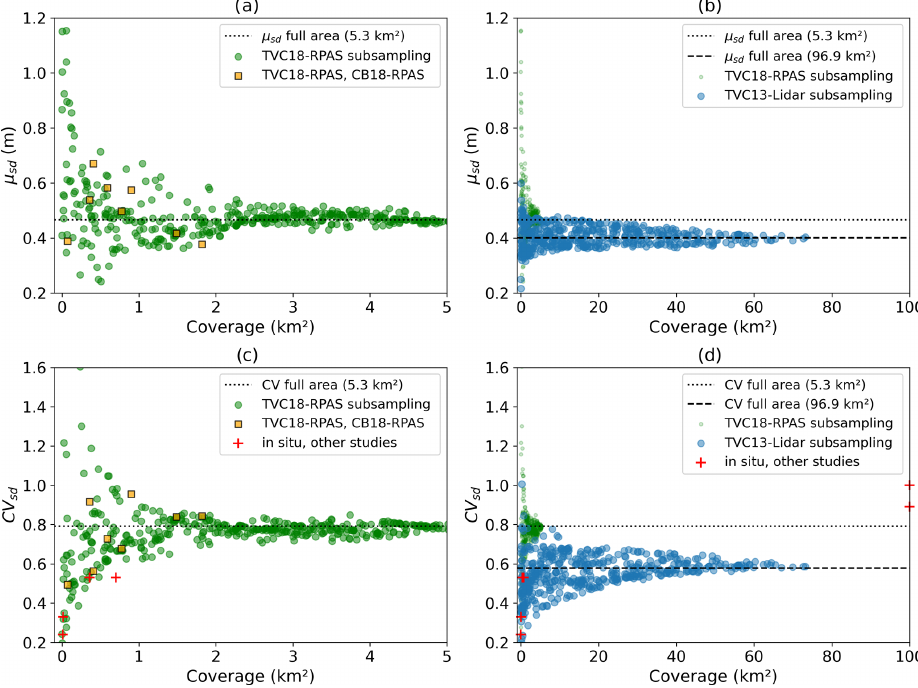
Figure 4. Snow depth mean ( µ sd ) (a, b) and variability (CV sd ) (c, d) as a function of coverage for sampling area: (a, c) small area; (b, d) large area. Monte Carlo simulations were done using the two datasets in TVC. CB18-RPAS was also added in panels (a) and (c) because of the similar coverage. The µ sd and CV sd of both full areas are shown by the black dotted and dashed